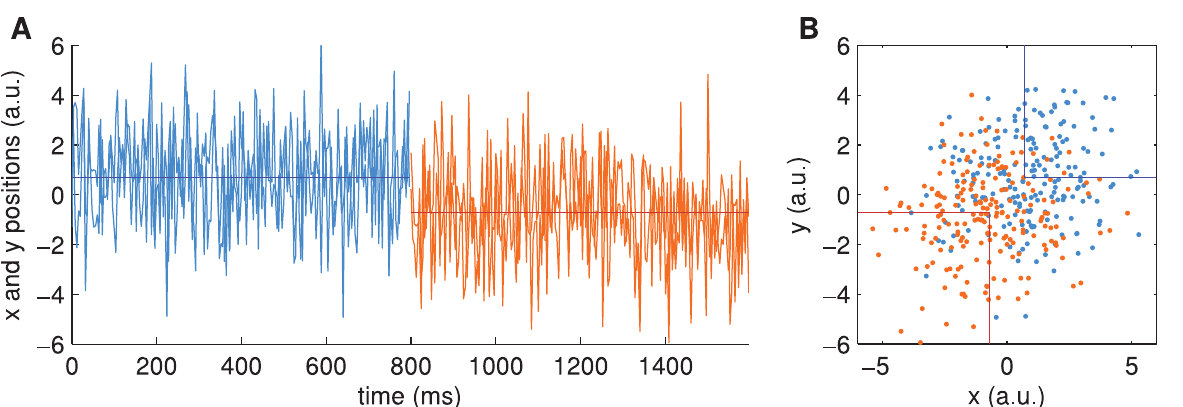
Fig 2. Example stimulus of single dot task, with a switch of target location. (A) The plot shows both x- and y- positions of the single dot throughout an example trial of 1600ms length. Every 40ms a new dot position is drawn. For 800ms positions are drawn from the first target (blue), i.e., a Gaussian with mean position [0.71, 0.71] (dark blue horizontal line) and standard deviation s = 2 in both dimensions. For the next 800ms positions are drawn from the second target (orange) around the mean [-0.71, -0.71] (red horizontal line) with the same standard deviation. (B) Same data as in (A), but plotted in 2D coordinates as when presented on a screen. Note that the observer would see only a single dot of neutral colour at any time throughout the trial and would have to decide whether the dot moves around the first (lower left) or second (upper right) target (indicated by lines).